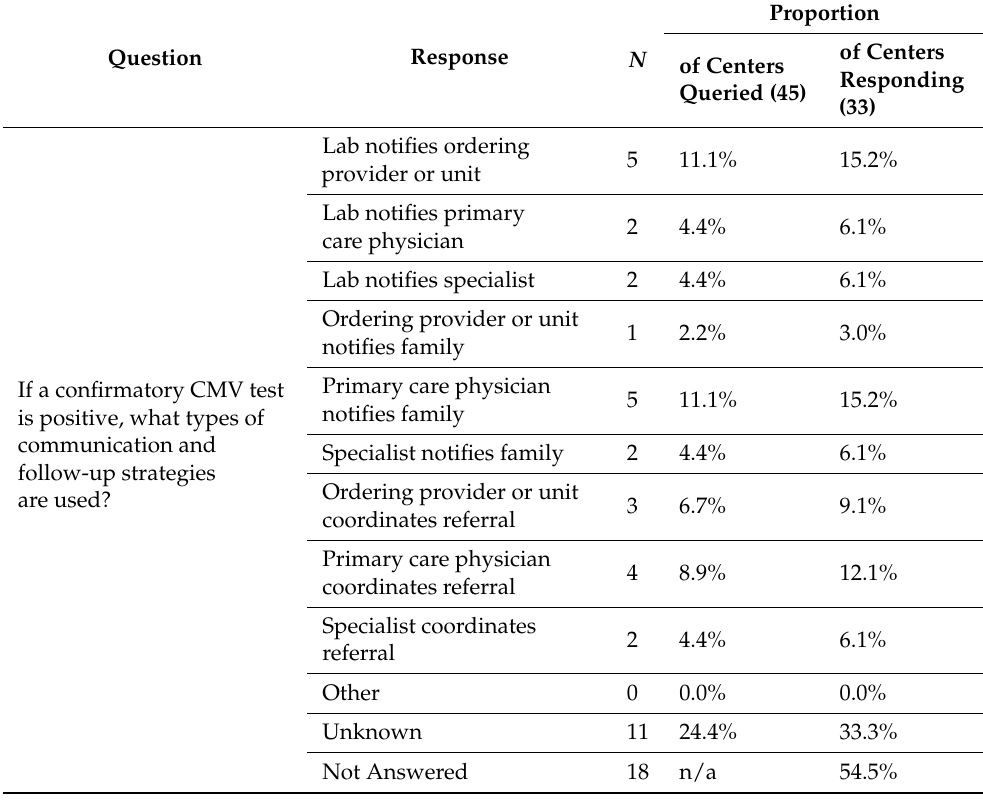
Table 6. Responses regarding communication of cCMV screening results.